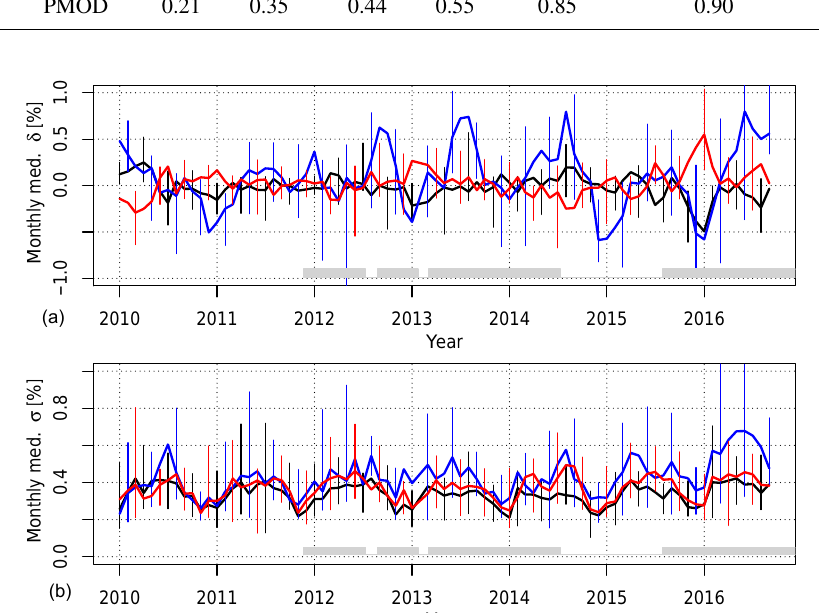
Figure 6. Time series of the monthly median offset δ (upper panel) and median SDs σ (lower panel) over the time period 2010–2016. The black, blue and red lines correspond to Brewer B 040 , B 072 and B 156 instruments. The error bars corresponding to the interquantiles Q 97 . 5% – Q 2 . 5% ranges are displayed every third month for clarity. The gray areas show the time periods when the Brewer B 072 instrument was located at